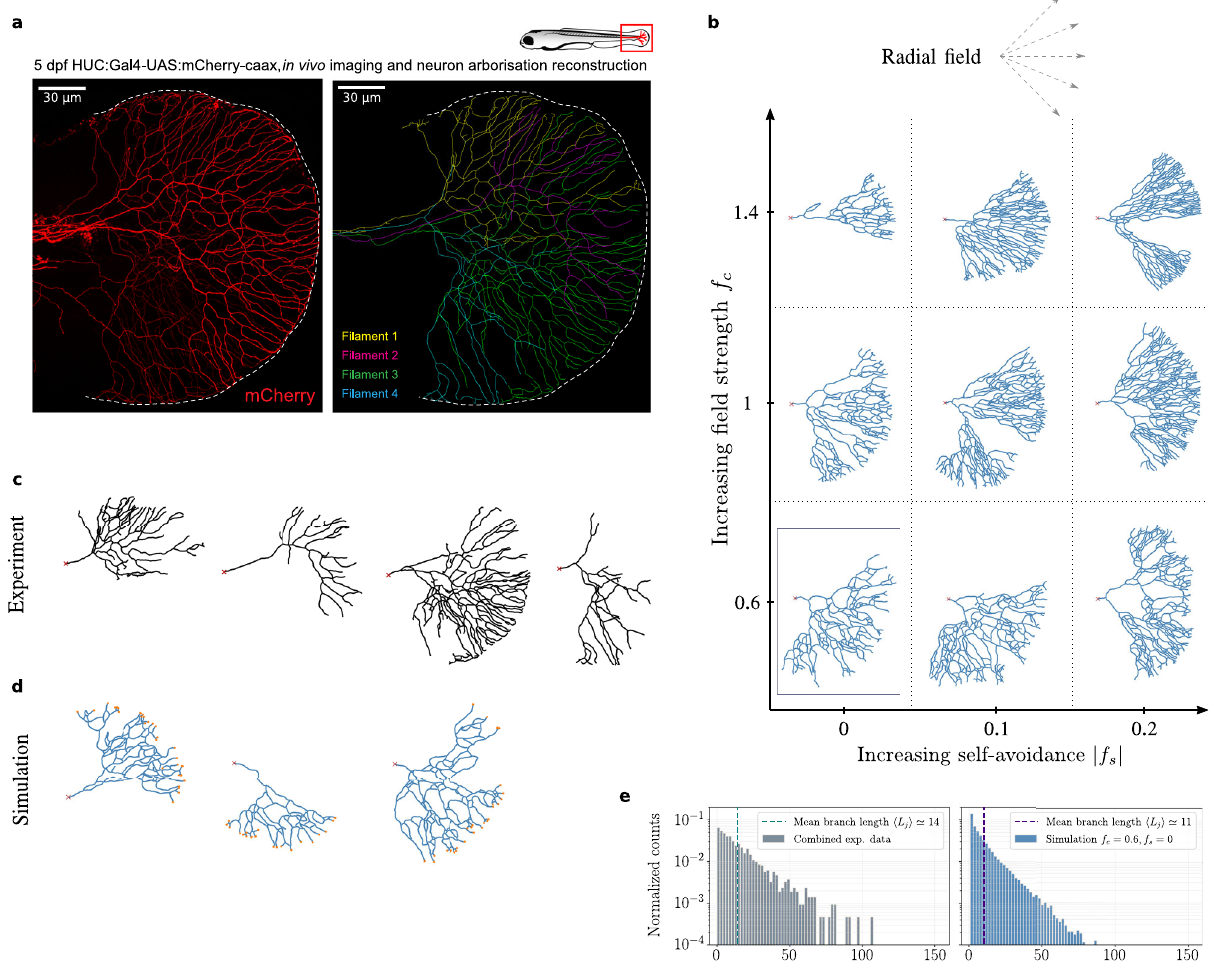
Fig. 2 Branching and annihilating random walks (BARWs) with radial guidance cue reproduces qualitative features of zebra fi sh caudal fi n innervation. a Development of the zebra fi sh nervous system and innervation of the caudal fi n (boxed area in the top right cartoon) 5 days postfertilization. (Left) Confocal image of neuronal cell membranes in the caudal fi n imaged via red mCherry fl uorescence (HUC:Gal4-UAS:mCherry-caax). Imaged Rohon-Beard sensory neurons exhibit a clear directionality toward the fi n edge (indicated by the dashed white lines). (Right) Different manually reconstructed neuronal trees color-coded for visualization. b Morphology of branched structures with the same model as in Fig. 1, but in a radial external fi eld (dashed arrows, top) obtained from simulations for different values of the external fi eld strength f c and self-avoidance ∣ f s ∣ . c – d Simulations with an intermediate external fi eld strength ( f c = 0.6) and no self-avoidance ( f s = 0), corresponding to the boxed region in the morphology diagram ( b ), capture the overall directionality observed in reconstructed networks (four representative neurons, red cross indicating “ origin ” of the axon, c ), but also show some stochasticity in the fi nal network structure as in the data. Active tips of the simulated branching networks are highlighted in orange. e Branch lengths L j (in normalized units) obtained from experiments (left) and simulations (right) are distributed exponentially, de fi ning a characteristic length scale 〈 L j 〉 related to the branching probability p b , as predicted by our theory of stochastic branching. Experimental data are obtained from n = 8 reconstructed neuronal fi laments from N = 4